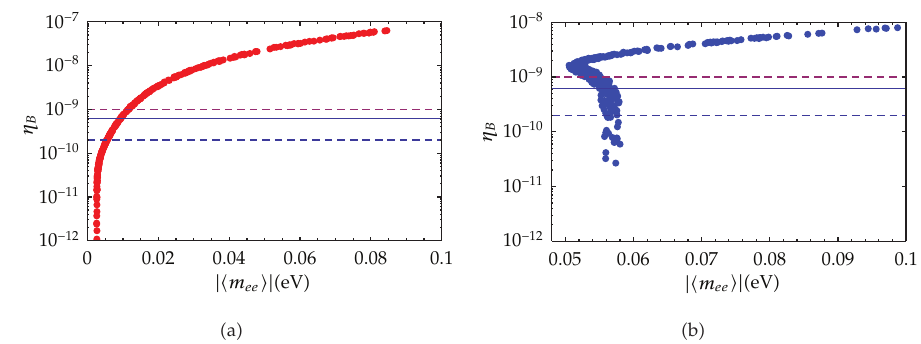
Figure 7: Prediction of η B as a function of |(cid:2) m ee (cid:3)| for the NH case (cid:2) a (cid:3) and IH case (cid:2) b (cid:3) . The horizontal solid and dashed lines correspond to the experimental central value and phenomenologically allowed